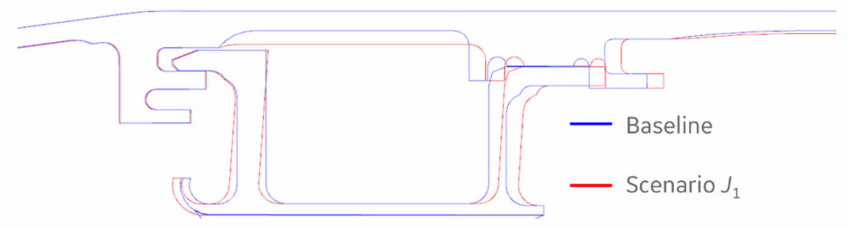
Figure 23. Geometry comparison between baseline and proposed configuration (scenario J 1 ).